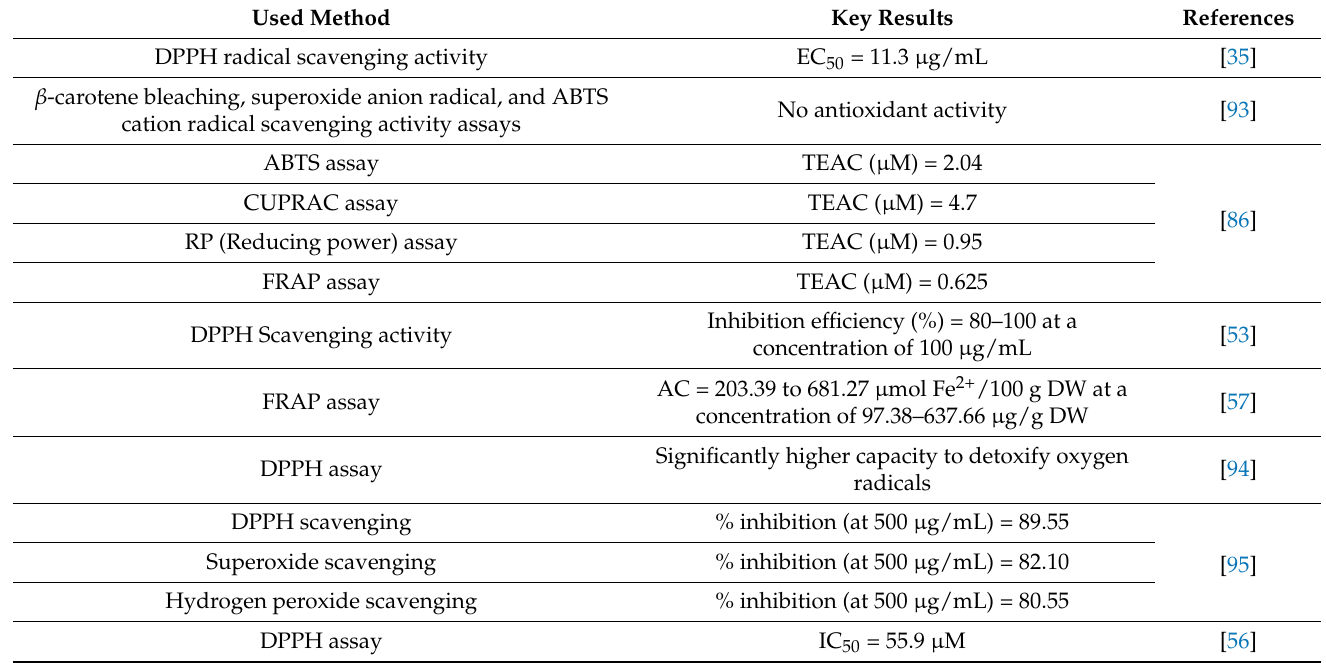
Table 3. Antioxidant activities of cirsimaritin.